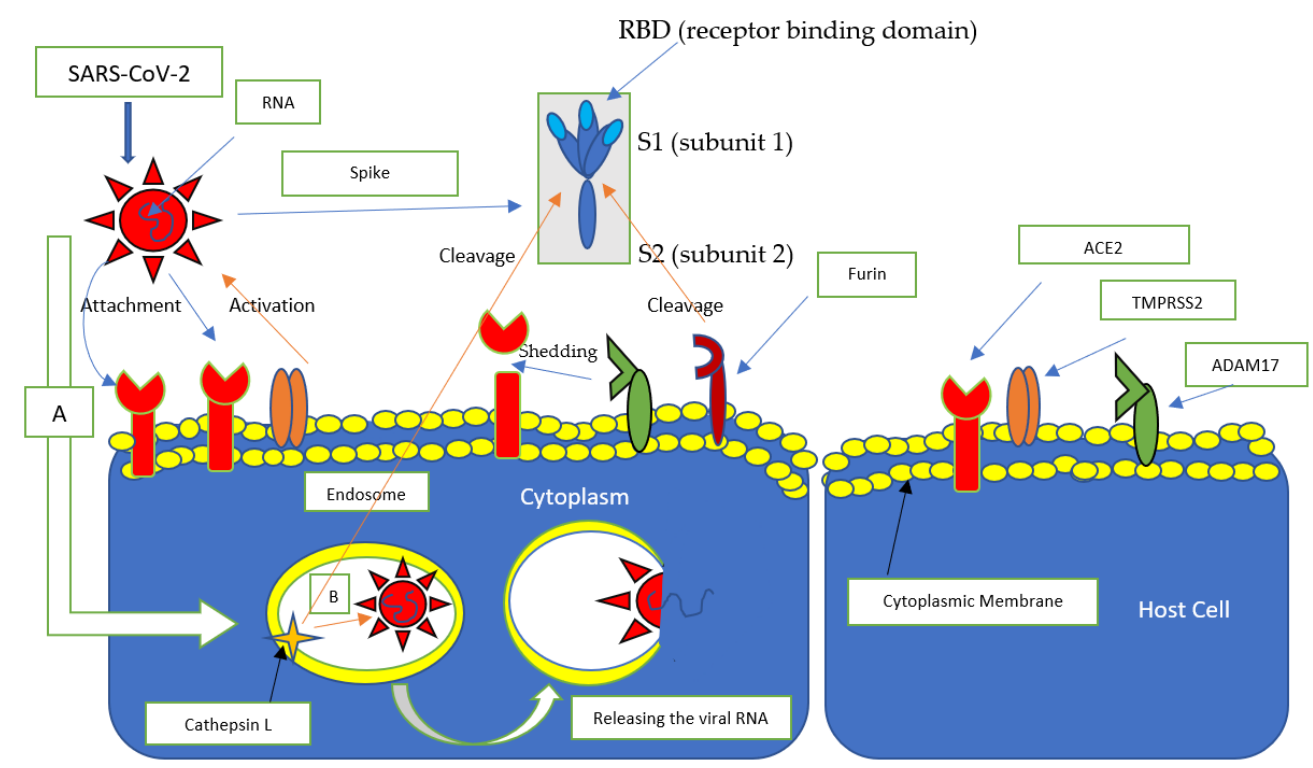
Figure 2. The primary receptors involved in the entry of SARS-CoV-2. SARS-CoV-2 binds to the ACE2 receptor via the spike protein; specifically, ACE2 binds to the S1 subunit at the RBD (Receptor Binding Domain) level, TMPRSS promotes binding by interacting with the spike protein, while Furin detaches the bond between the S1 and S2 subunits, favoring the fusion of the virus capsid with the cytoplasmic membrane. ADAM17 is responsible for the shedding of the ACE2 receptor. ( A ) The virus penetrates cells through endocytosis, after binding with the ACE2 receptor, ( B ) forming an endosome where cathepsin L cleavage of the spike protein releases viral RNA.